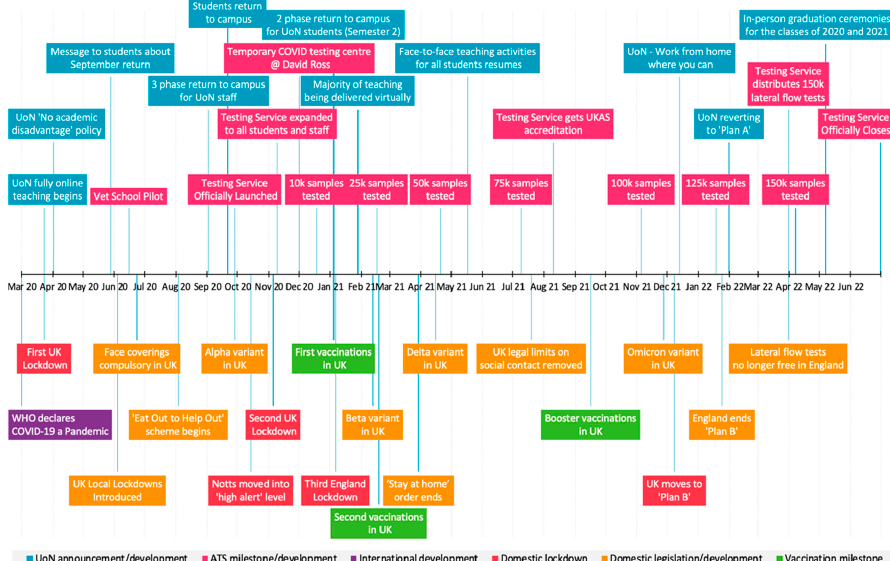
Figure 1. Deployment of Asymptomatic Testing Service and the national COVID-19 context. UK: United Kingdom; WHO: World Health Organization; UoN: University of Nottingham; Notts: Not- tingham; Vet School Pilot [19]; David Ross: University sports facility and temporary testing site venue; Plans A and B (see www.gov.uk accessed on 28 September 2022) .